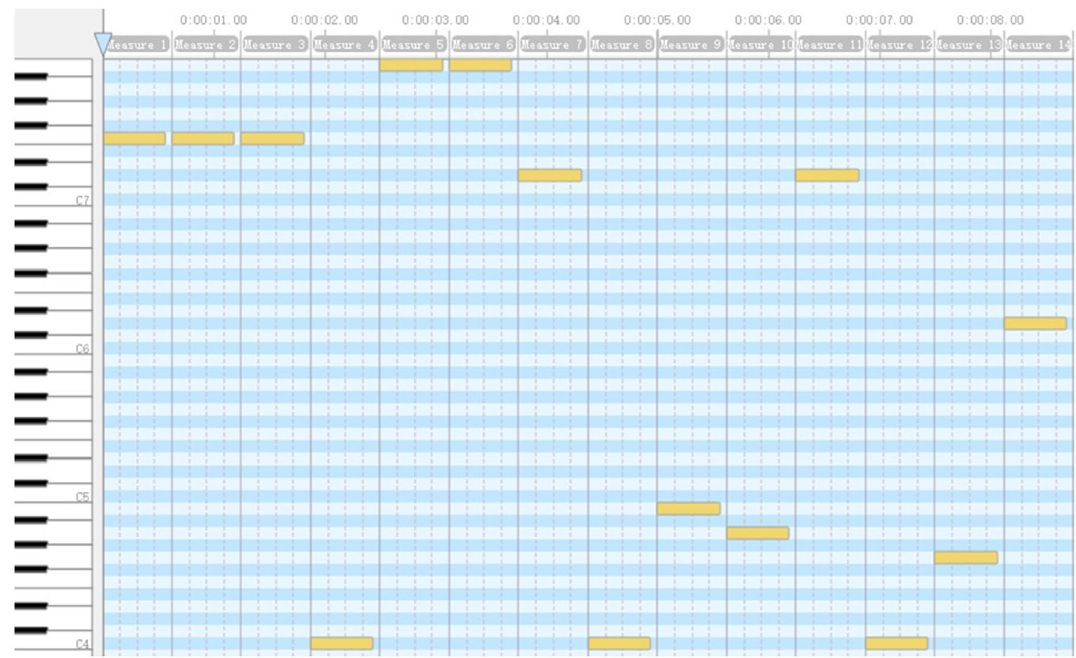
Figure 4. An example on AAQRC recognition: step 3: music score of f3.